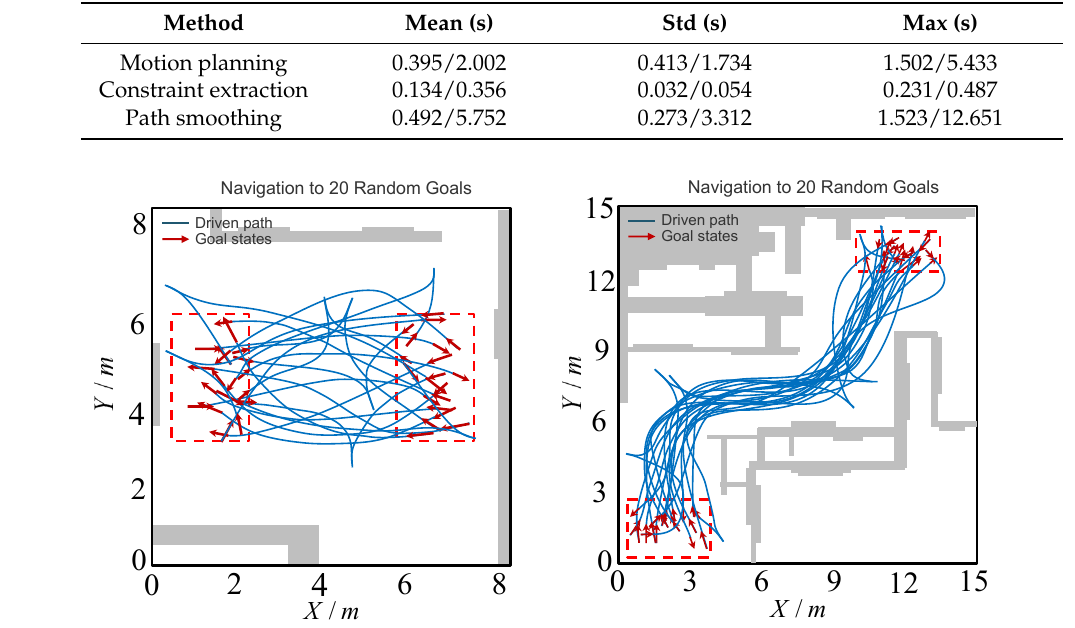
Table 3. Computational time for motion planning and path smoothing (short/long).